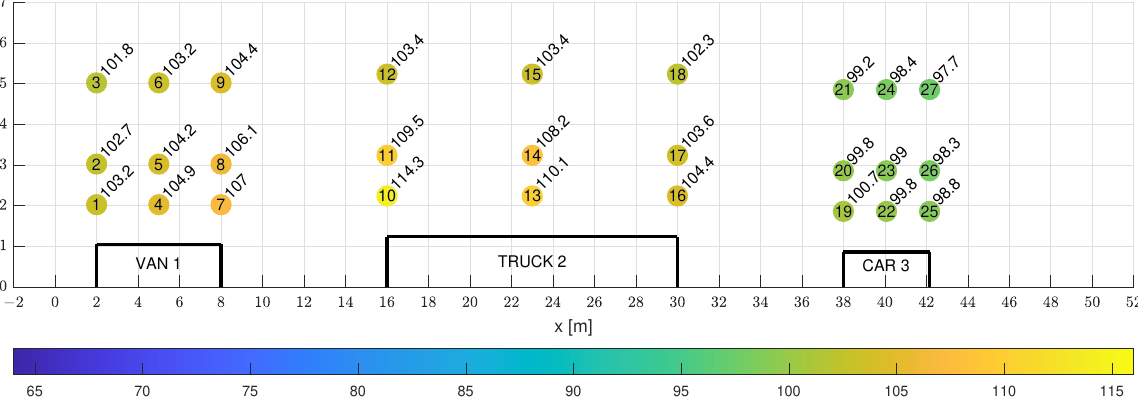
Figure 19. Overall sound pressure level in decibels (dB) on the side of the platoon, measured at receivers for the z-coordinate of 1.7 m. Spacing between trucks: 8 m. View from the top. On the basis of the analysis of the results (Figure 19) of the presented distributions of the overall sound pressure level for the column of cars, we can state that the highest levels occur at the distance of 1 and 2 m from the truck, i.e., at points 10, 13, 11. The lowest levels of the overall sound pressure level for the distance of 8 m between the vehicles were observed in the last section, i.e., at points 25, 26, 27. Additionally, the biggest difference in the overall sound pressure levels was observed between points 10 and 12 and it was 10.9 dB, and the smallest difference was 1.1 dB between points 25 and 27.